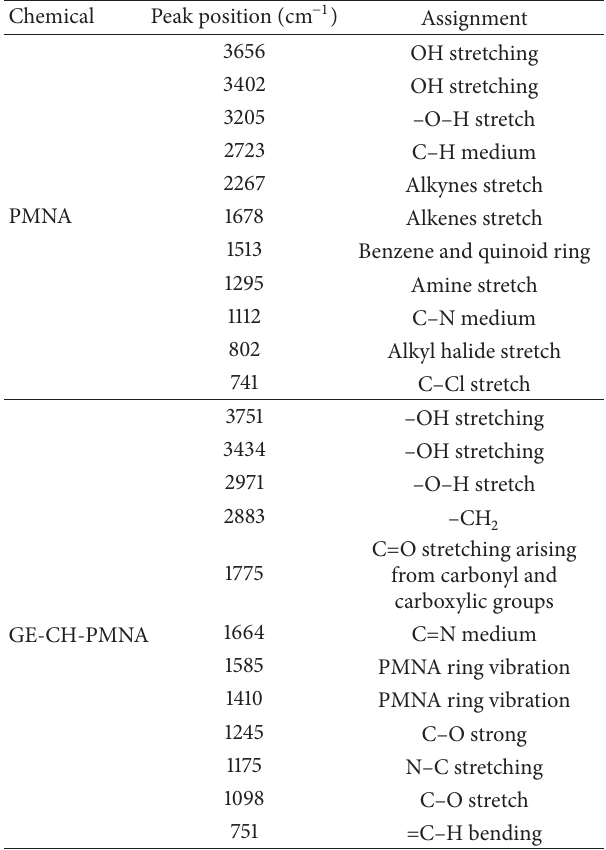
Table 1: FTIRdippositionsand theiroriginforPMNAand GE-CH-